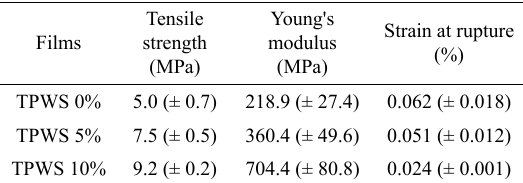
Table 2. Young's modulus, tensile strength, and strain at rupture of the films.